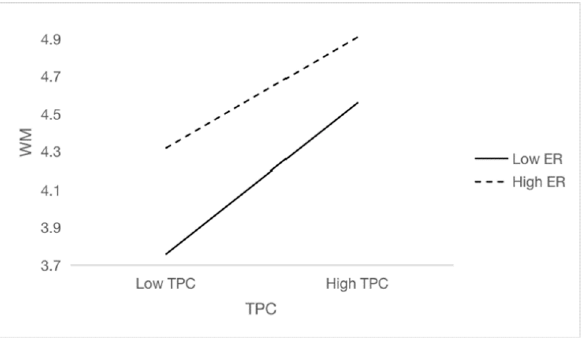
Figure 2. The moderating effect of ego-resiliency on teachers’ psychology capital and work-meaning cognition.